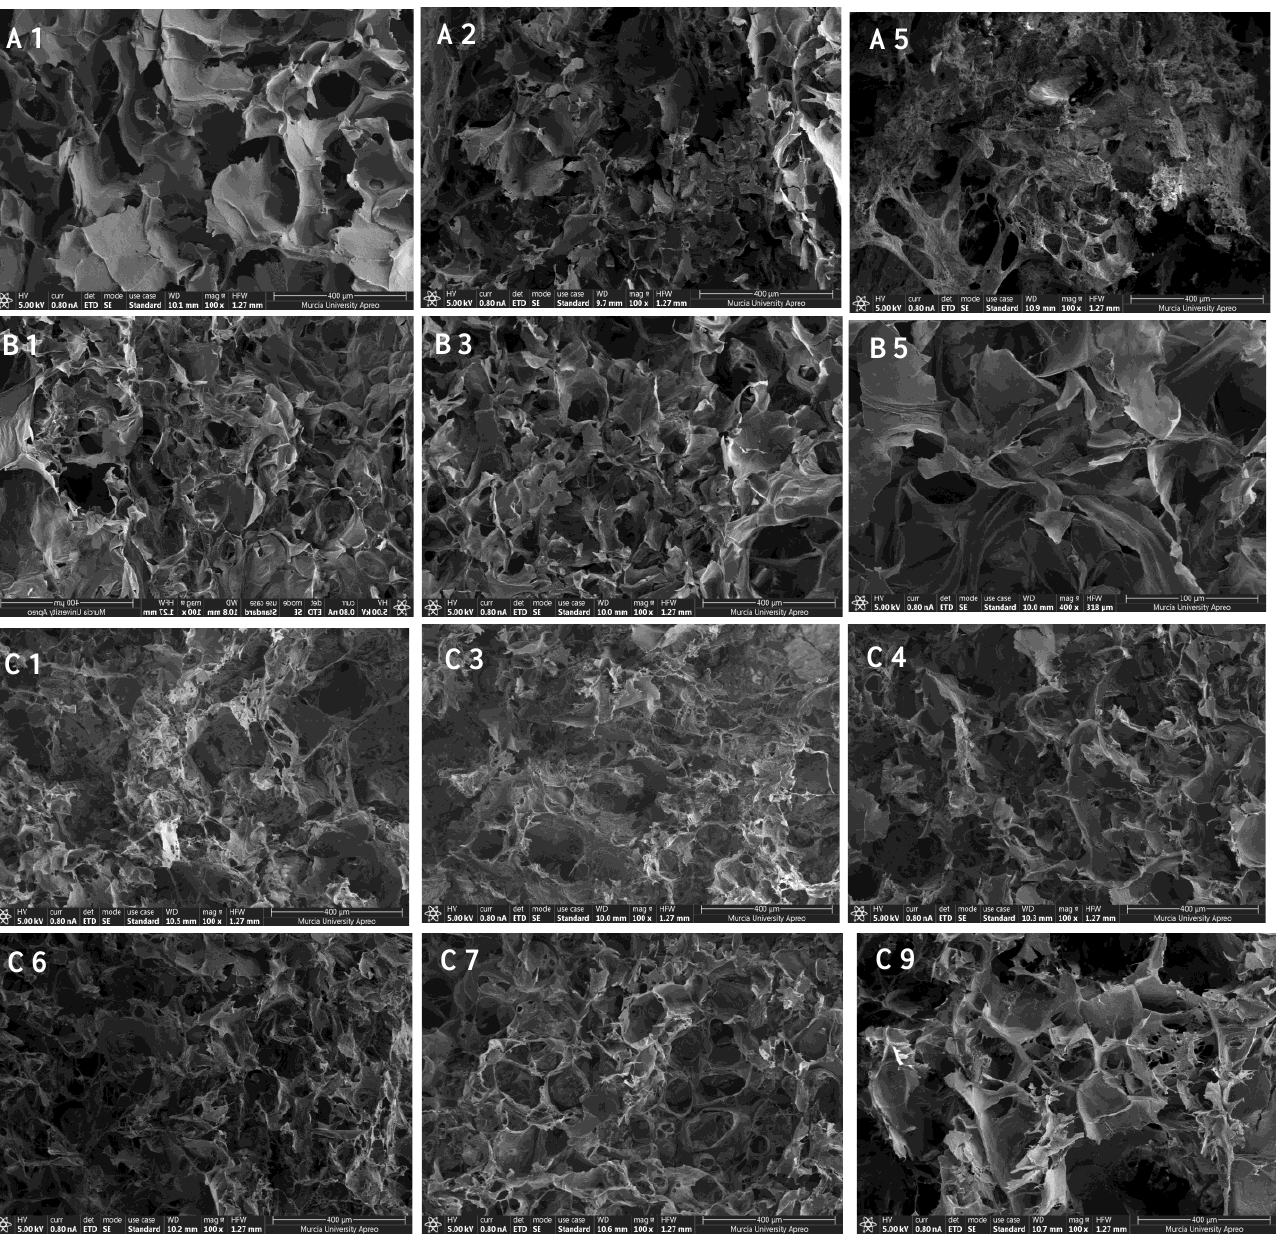
Figure 6. Observationof the morphology by FESEM of SF ( A1 , B1 ), SF/HA ( A2 , A5 ) and SF/curcumin hydrogels ( B1 , B3 , B5 ); SF/HA/curcumin hydrogels with SF/HA = 80/20 ( C1 , C4 , C7 ) and SF/curcumin = 40/60 ( C3 , C6 , C9 ).